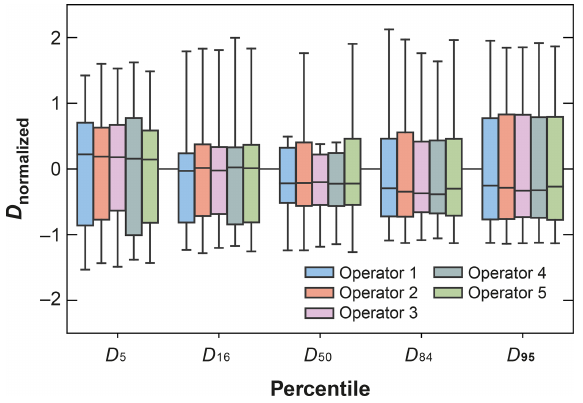
Figure 3. Boxplot of normalized grain size D normalized for per- centiles D i for five human labeling